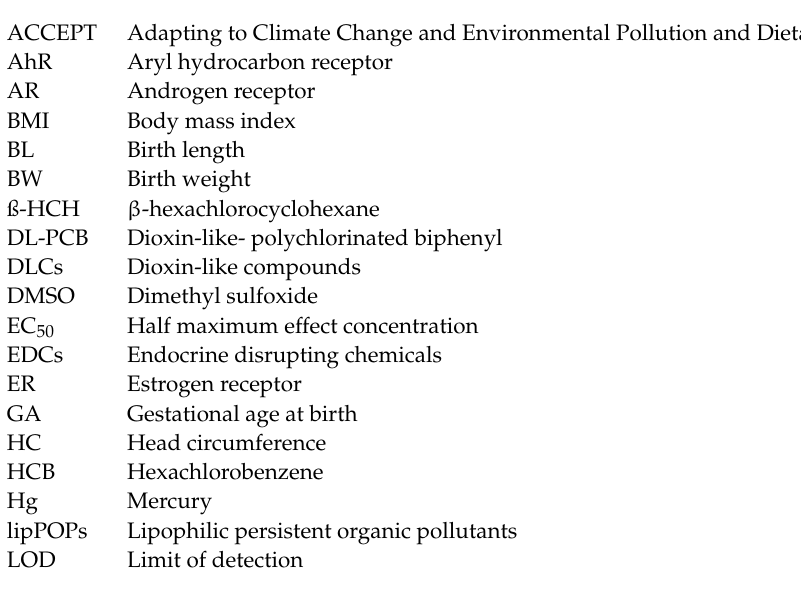
.3390/toxics10010026/s1, Figure S1: the association of quartiles of AhR-TEQ (pg/g) and fetal growth indices. Table S1: levels of lipophilic POPs and dioxin-like activity in maternal serum and fetal growth indices stratified by infant gender; Table S2: the detectable percentage of contaminants in ACCEPT Inuit pregnant women; Table S3: rotated factor loading of two components identified by principal component analysis of the ACCEPT Greenlandic pregnant women; Table S4: the associations of maternal serum AhR-TEQ (pg/g lipid) and fetal growth indices; Table S5: the association of maternal serum (AhR-TEQ, pg/g lipid) and fetal growth indices stratified on gender in the ACCEPT cohort; Table S6: the association of maternal serum AhR-TEQ (pg/g lipid) and fetal growth indices stratified on smoking history of the ACCEPT cohort; Table S7: the association of serum AhR-TEQ (pg/g lipid) and fetal growth indices stratified by gestation age in ACCEPT